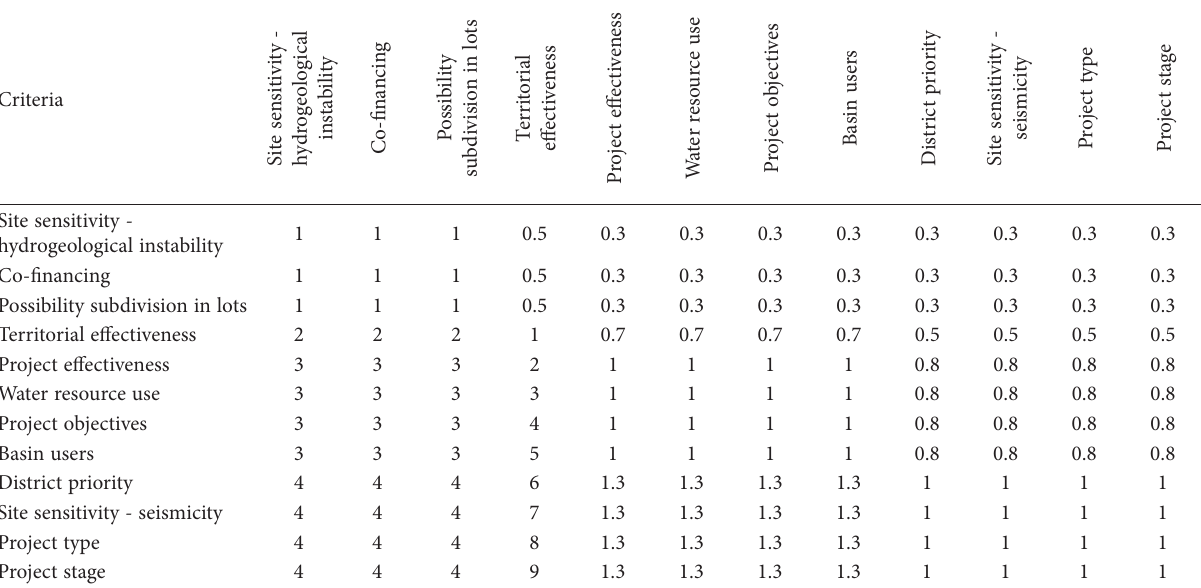
Table 2. Criteria order: Score matrix.